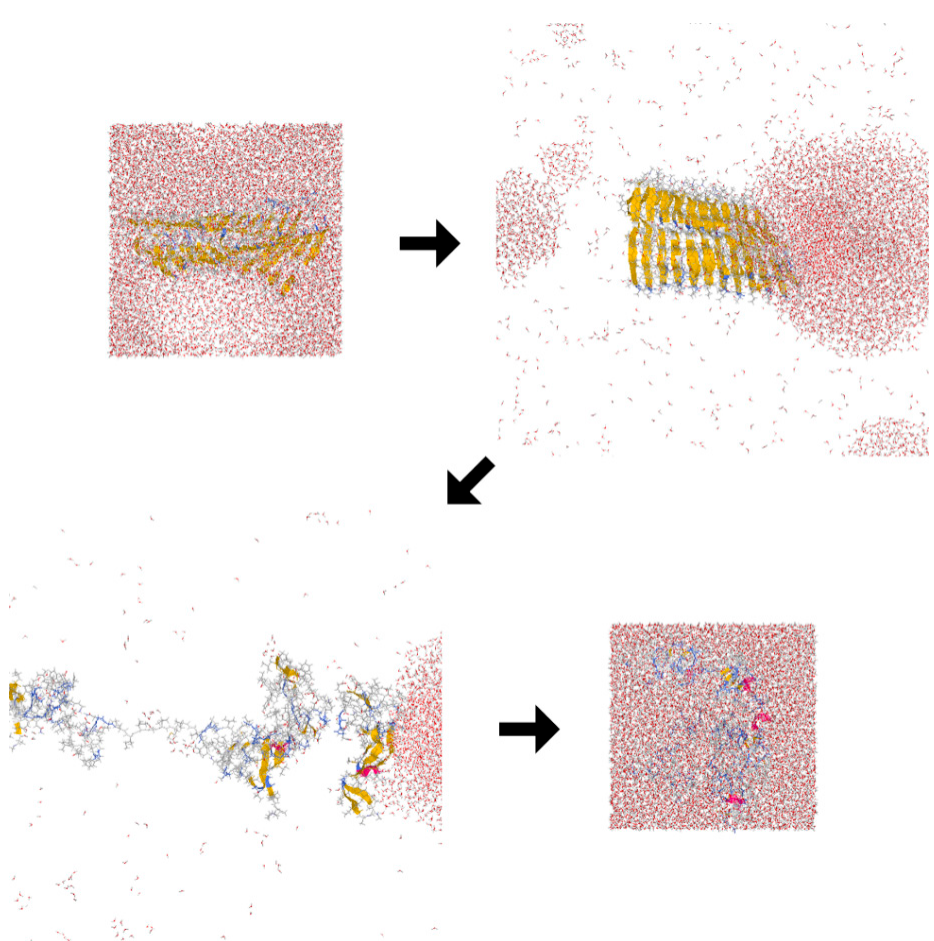
Figure 13. Snapshots of the destruction of the A β amyloid fibril by ultrasonic waves. The amyloid fibril was destroyed by the jet flow generated when the bubble collapsed. Reprinted with permission from Ref. [80]. Copyright 2014 American Chemical Society.